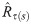
Selection for pandemic influenza (1918).Left graphs compare R^τ(s) estimates (blue with 95% confidence intervals) at optimal APE window length k* to weekly sliding windows (k = 7), which were recommended in [10]. Right graphs give corresponding one-step-ahead predictions x|Is-k+1s (blue with 95% prediction intervals). Dashed lines are the R = 1 threshold (left) and dots are the true incidence Is (right). Panel (A) directly uses the empirical influenza (1918) data [10] while (B) smooths outliers in the data as in [16].